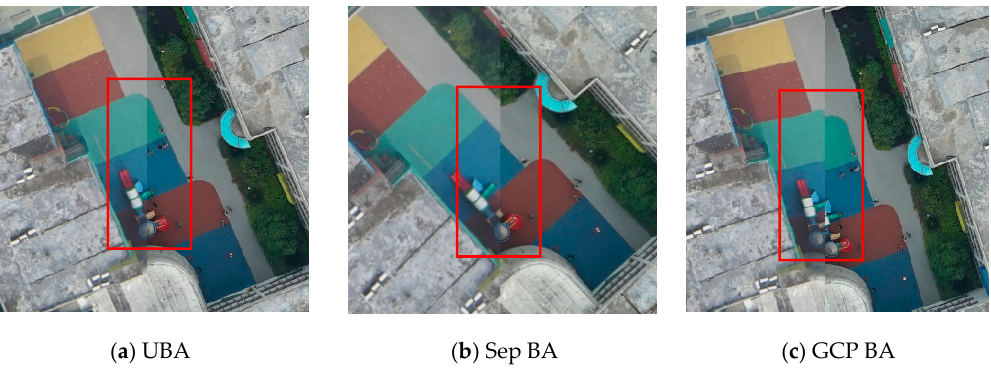
Figure 4. Orthophoto co-registration results for: ( a ) united bundle adjustment (UBA); ( b ) separated bundle adjustment (Sep BA); and ( c ) ground control points bundle adjustment (GCP BA). The left sides of each three subsets are orthophotos from reference flight, and the right sides are orthophotos from the following flight.